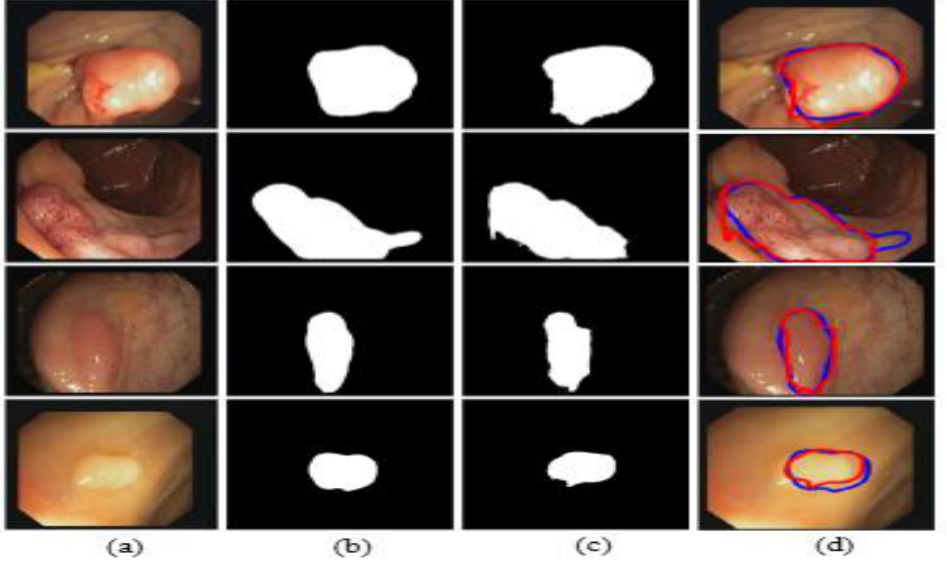
Figure 16. Comparison of ground truth and output mask on the CVC-ClinicDB dataset. ( a ) Original Image; ( b ) ground truth; ( c ) output mask; and ( d ) combined.